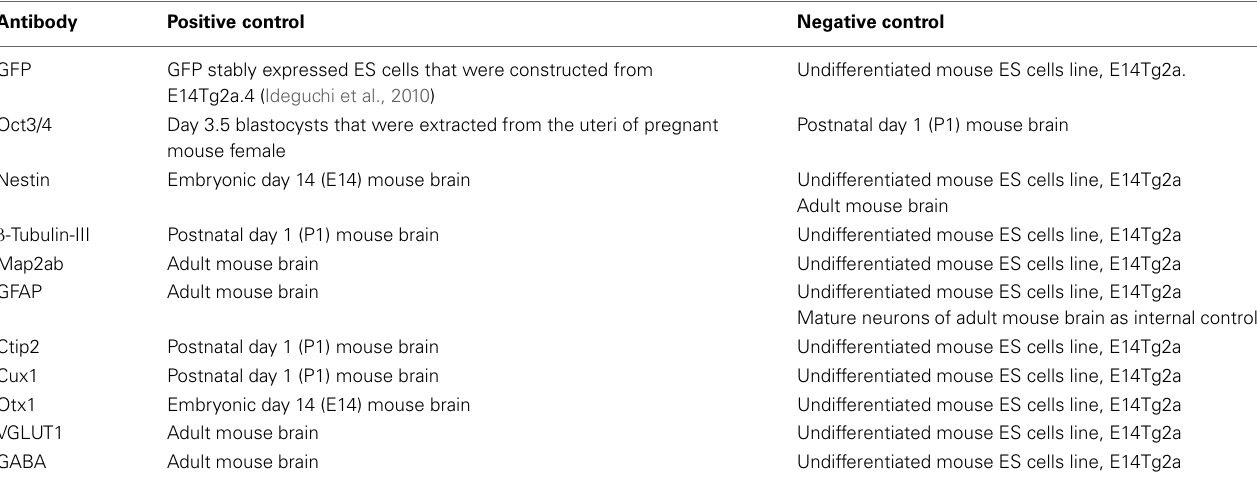
Table 2 | Tissue type controls used in this study.